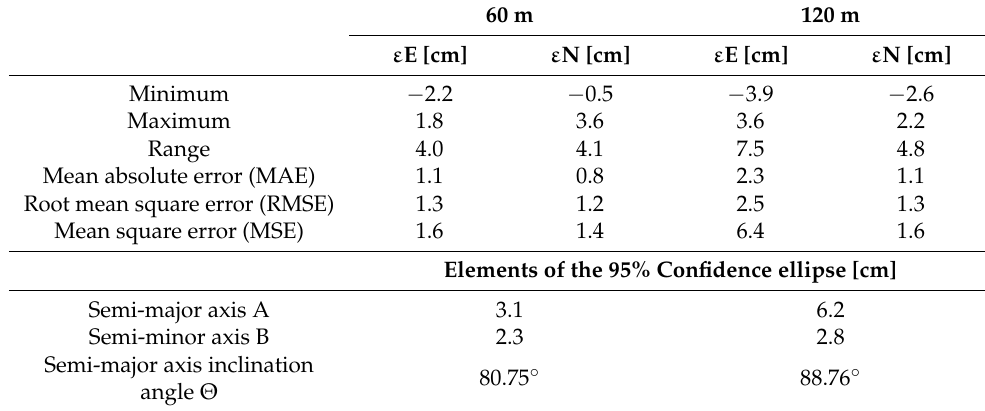
Table 5. UAS DJI Phantom 4 Pro V2.0—achieved data quality with the use of Table 9. Calculated distance differences between point pairs 7 and 19, and 11 and 15.